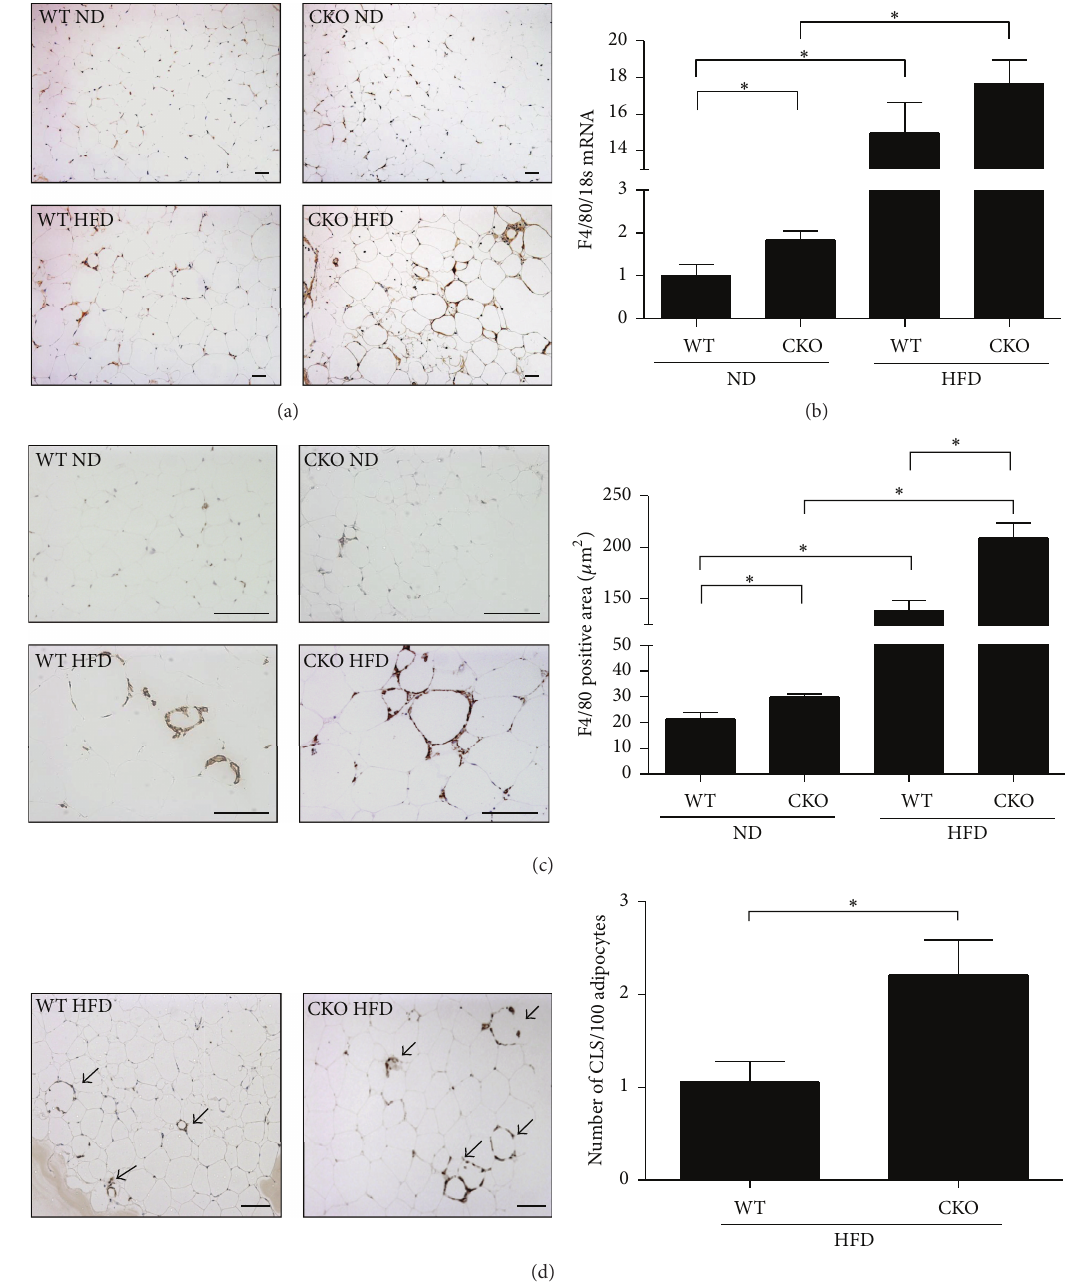
Figure 1: Catalase deficiency accelerates oxidative stress, macrophage infiltration, and crown-like structures in epididymal WAT. (a) Immunohistochemistry for nitrotyrosine (1: 200), a marker of oxidative stress. Scale bar, 50 𝜇 m; magnification, 100x. (b) F4/80 was assessed by real-time PCR and (c) immunohistochemistry (1:100) to measure macrophage infiltration. Immunostaining was quantified in Image Pro. Scale bar, 100 𝜇 m; magnification, 200x. (d) Crown-like structures in M1 macrophages were also quantified by immunohistochemistry for F4/80 (1:100, brown) and image analysis in Image Pro. Scale bar, 100 𝜇 m; magnification, 100x. Tissues were costained with hematoxylin (blue). Data are mean ± SE of 6–8 mice, and representative immunohistochemistry images are shown. ∗ 𝑝 < 0.05